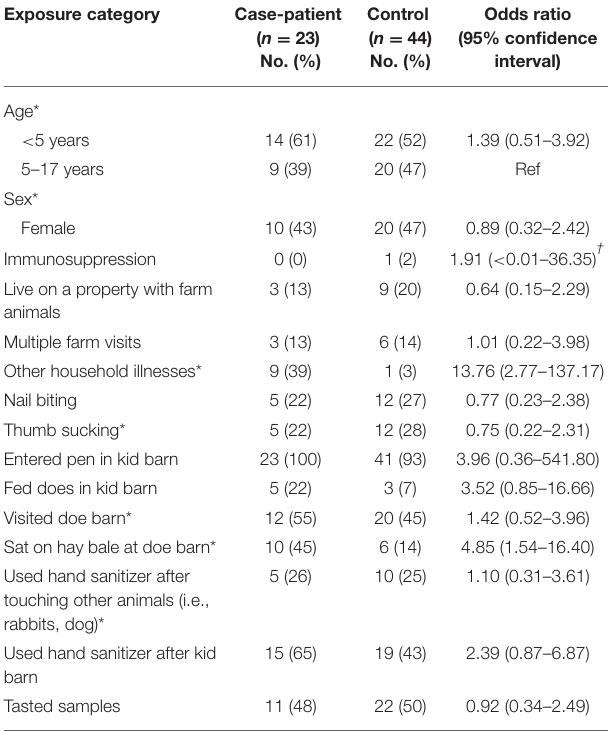
TABLE 1 | Univariable analysis of other risk factors for STEC O157 infection among children visiting farm X—Connecticut, 2016 ( n = 67). Exposure